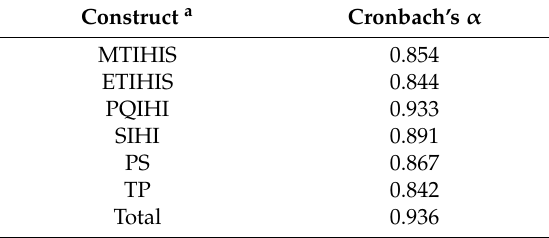
Table 2. Cronbach’s α of Constructs.